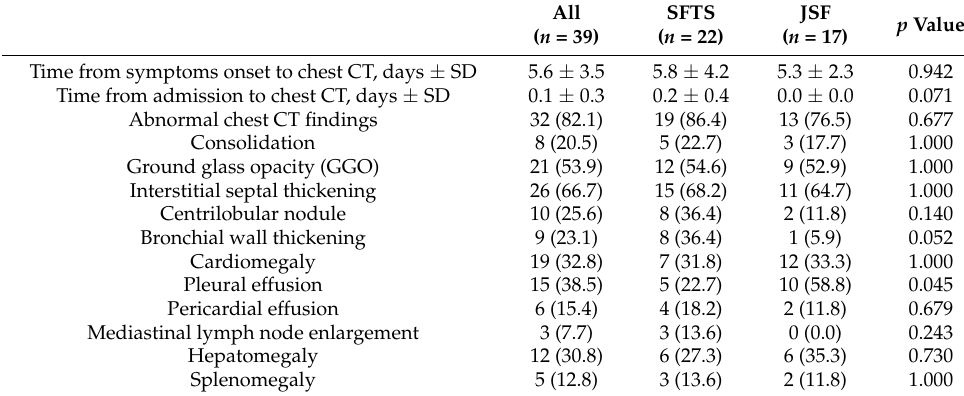
Table 4. Chest CT findings in patients with SFTS and